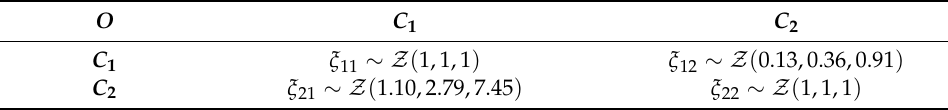
Table 7. Uncertain matrix for criteria C 1 and C 2 .